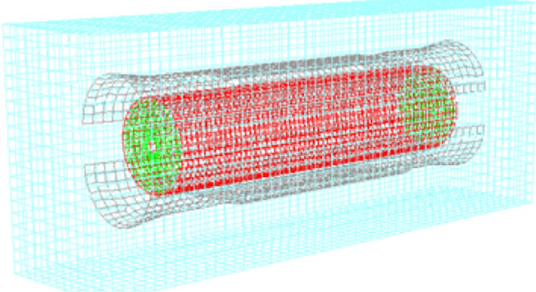
Figure 16 Finite element model based on the fluid–solid coupling method